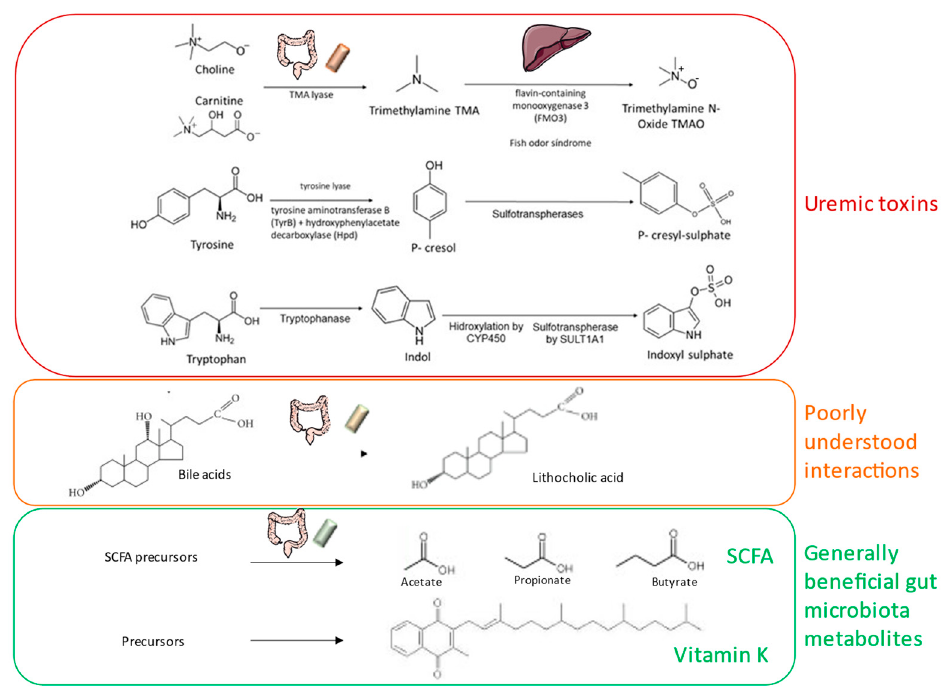
Figure 1. Biologically active molecules produced by the microbiota of interest for chronic kidney disease-mineral and bone disorder (CKD-MBD). SCFA: short-chain fatty acids.